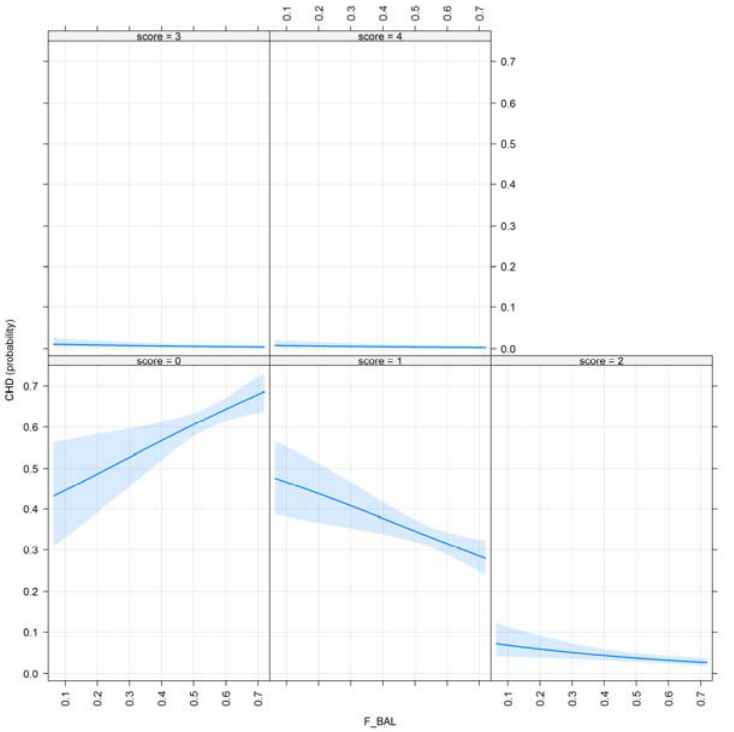
Figure 5. E ff ect plot of F _BAL for Figure 5. Effect plot of F _BAL for CHD.